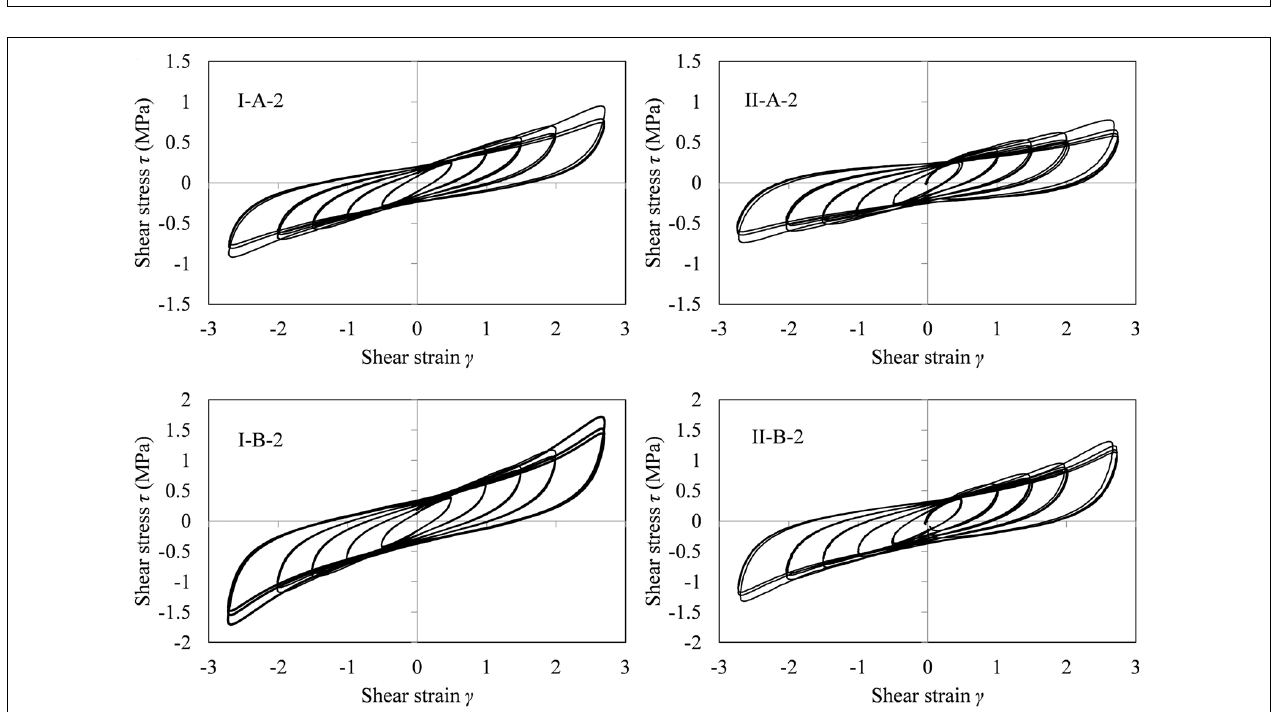
FIGURE 7 | Comparison of shear stress-strain relationship in shear strain dependence test of scale-I and -II for all three cycles.